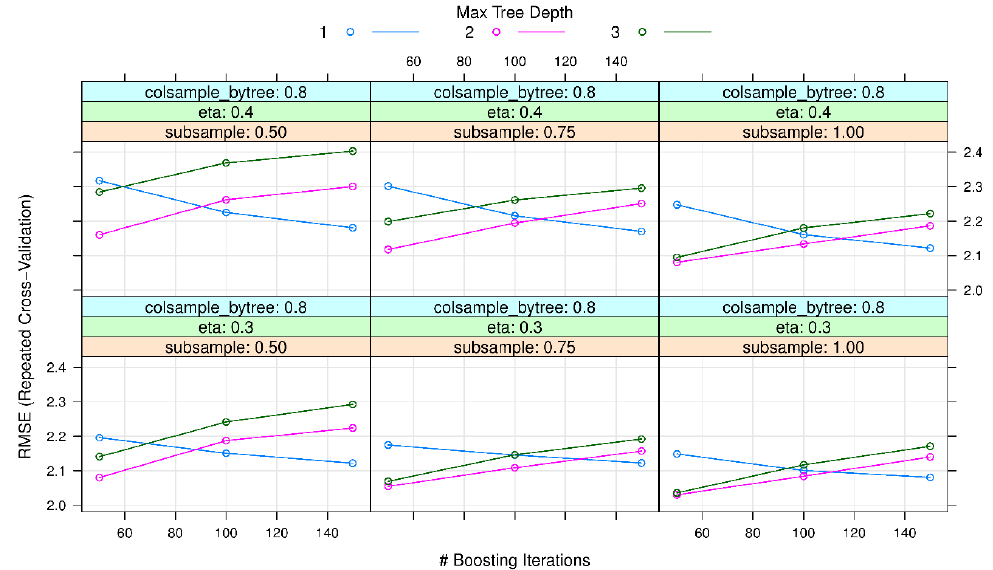
Figure 6. The development process of the classical XGBoost model for estimating HL.